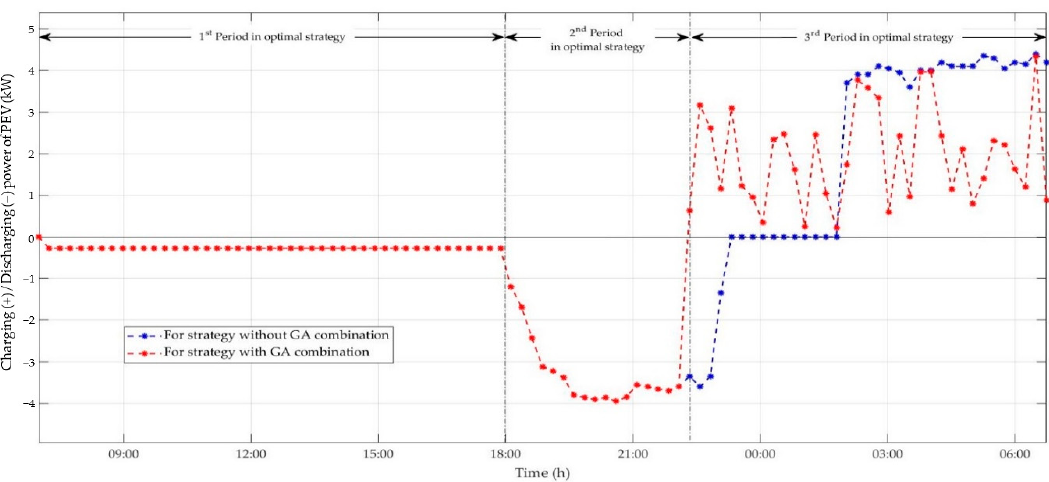
Figure 13. Comparison of charging (+)/discharging ( − ) power of the PEV using strategies with and without the GA.